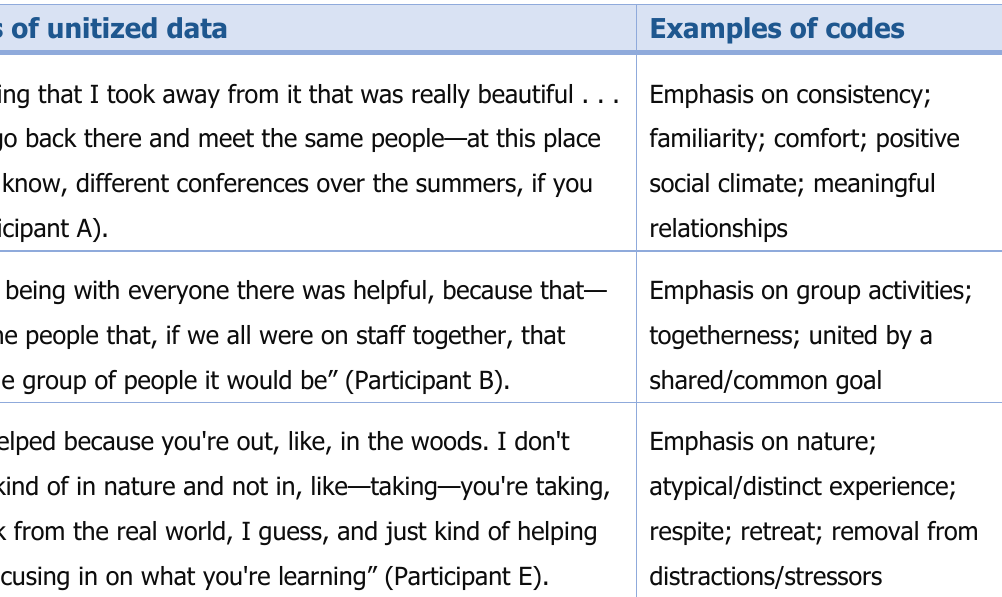
Table 1. Example of Unitized Data and Codes Examples of unitized data Examples of